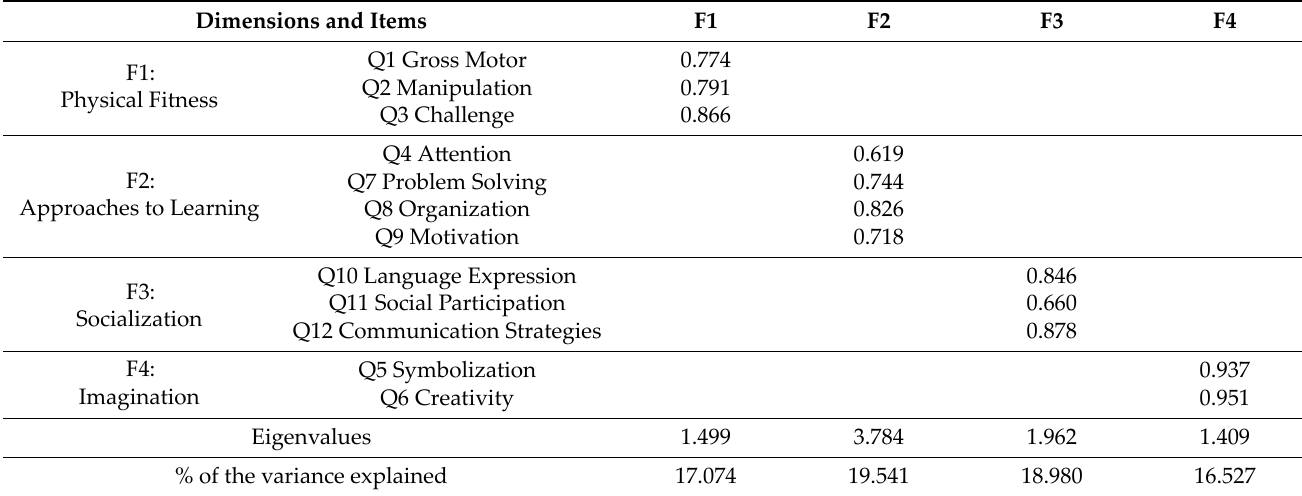
Table 2. Factor Loading of the Four Factors Identified in EFA.